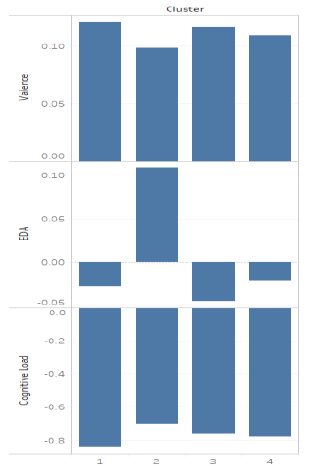
Figure 8. Participants’ overall valence, arousal and cognitive engagement during the experiment.